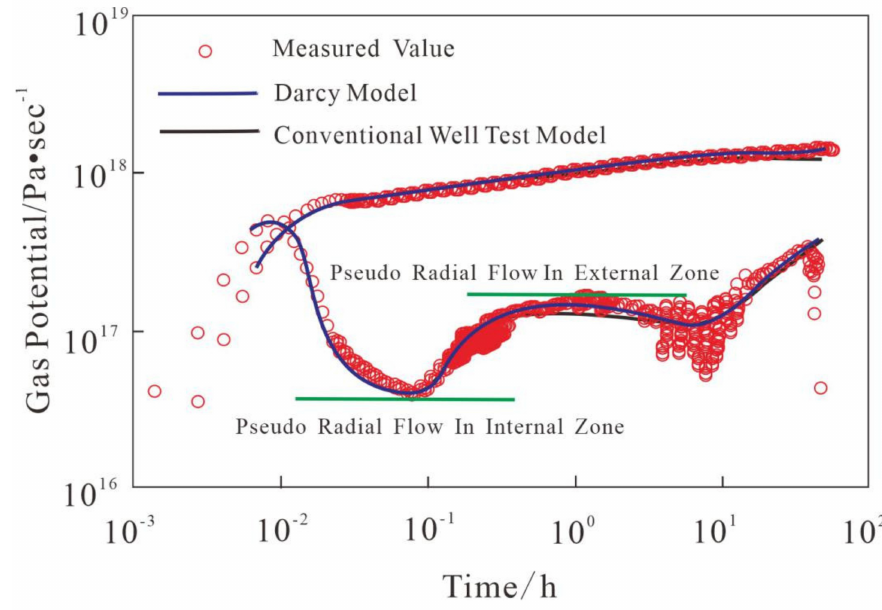
Figure 8. Dynamic pressure fitting curves of the actual example. Table 1. Basic parameters and well test interpretation results of well